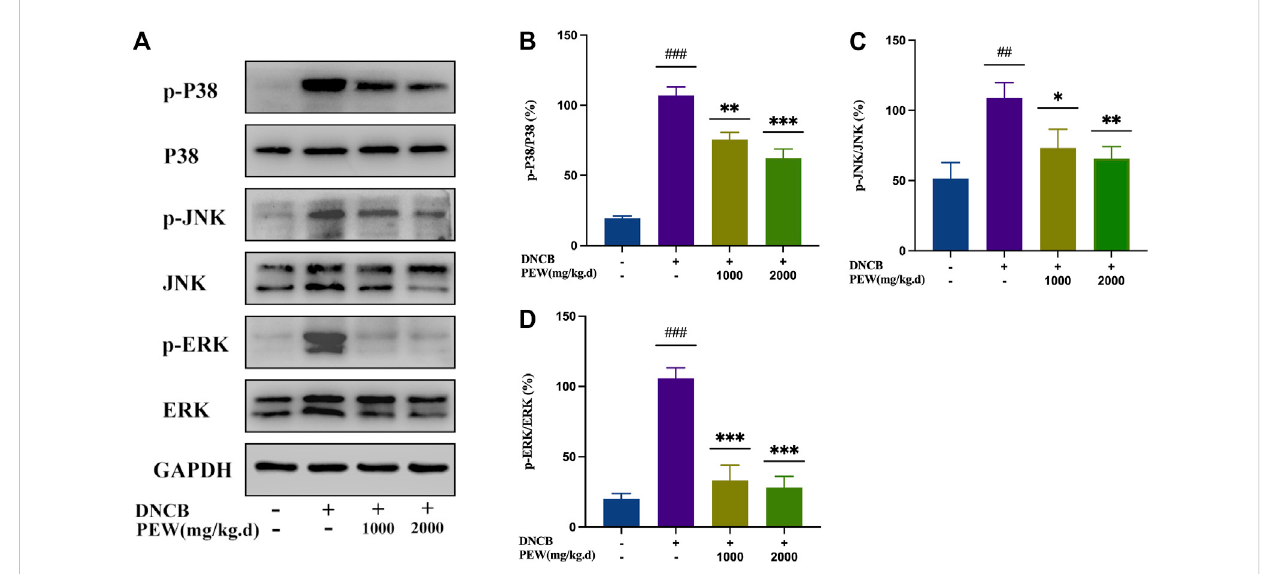
FIGURE 8 PEW suppressed the phosphorylation level of mitogen-activated protein kinases (MAPKs). (A) . Representative images of Western Blotting assays of p-p38, p38, p-JNK, JNK, p-ERK, and ERK. (B – D) . Expression of (B) p-p38 relative to p38, (C) p-JNK relative to JNK, and (D) p-ERK relative to ERK ( n = 3/ group). The data were presented as means ± SD. ## p < 0.01, ### p < 0.001 VS. the normal group; * p < 0.05, ** p < 0.01, *** p < 0.001 VS. the model control